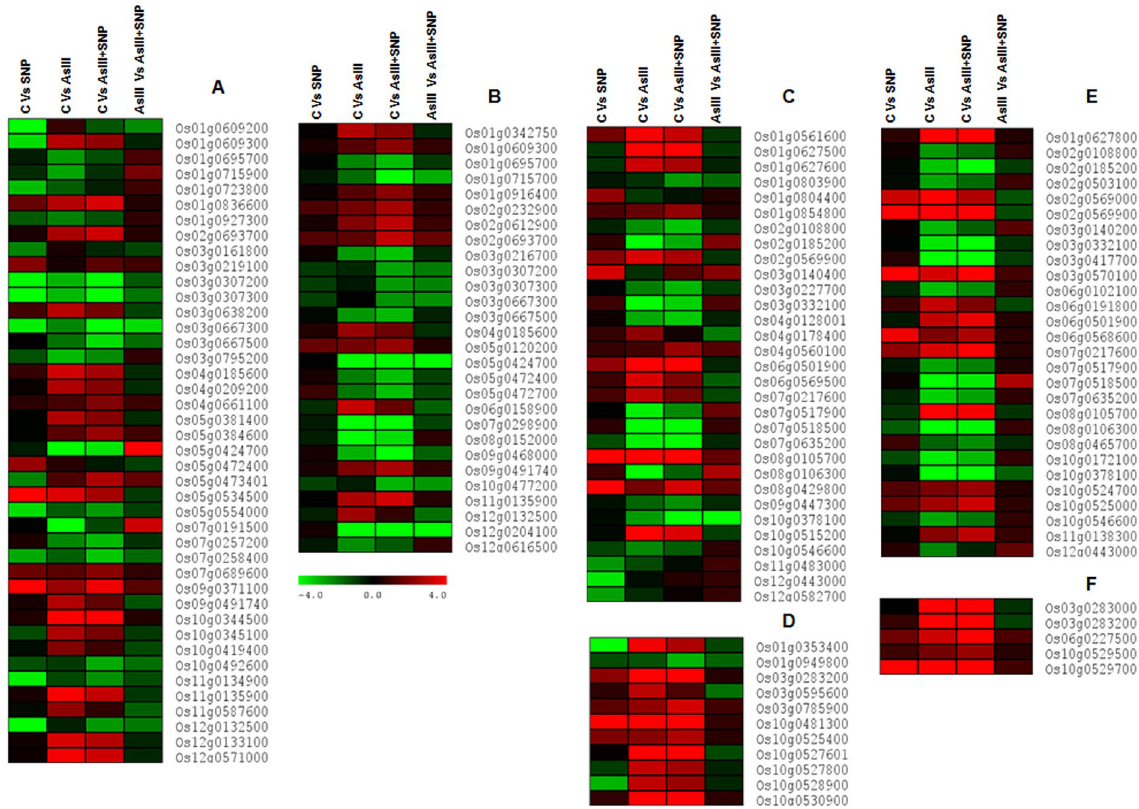
Figure 5. NO-mediated modulation of transporters and stress related genes. Differential expression patterns of NIP, ABCB, ABCC and ABCG transporter family proteins on 4 th day ( A ) and 12 th day ( B ) indicated their important role in AsIII detoxification. Expression behavior of Cyt P450 and GSTs were represented by ( C , D ) on 4 th day, while ( E , F ) represented the 12 th day. Several GSTs and peroxidase family genes showed up-regulation in the AsIII + SNP treatment indicated a protective role of NO in AsIII stress. Red and green color showed up and down-regulation of genes